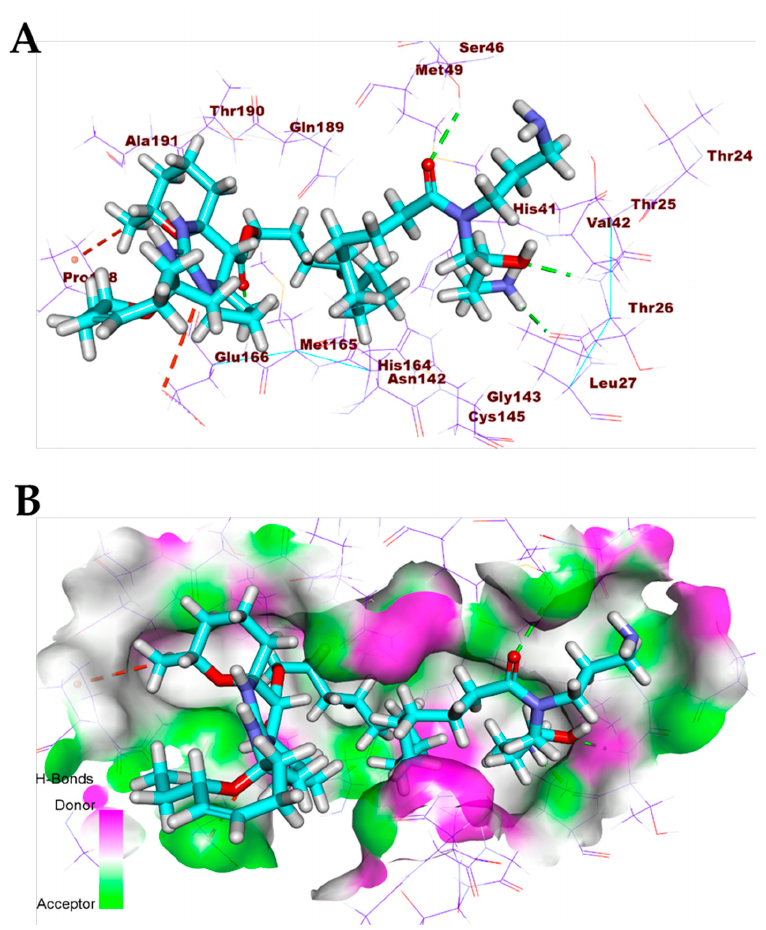
Figure 8. ( A ) Compound 5 docked into the active site of COVID-19 main protease. ( B ) Mapping surface showing com- pound 5 occupying the active pocket of COVID-19 main protease.